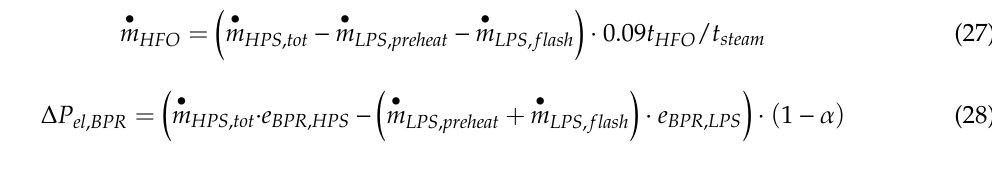
Table 5. Marginal backpressure electric energy production in the CHP unit, e BPR,p , in kWh per t of expanding steam to p -th pressure level, estimated with the turbine model from